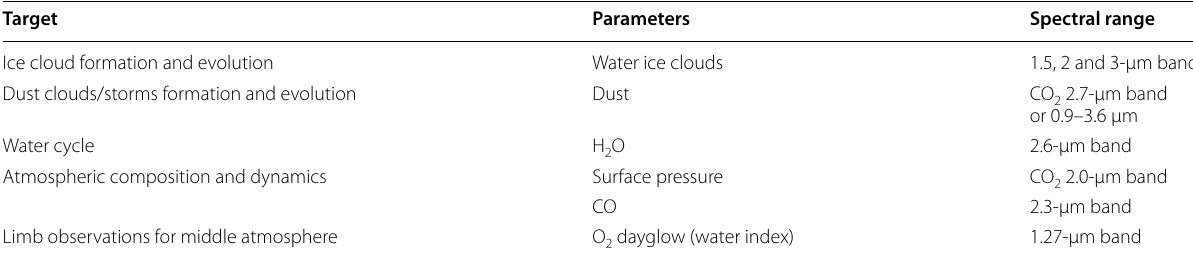
Table 1 Main targets of the Mars science measured by